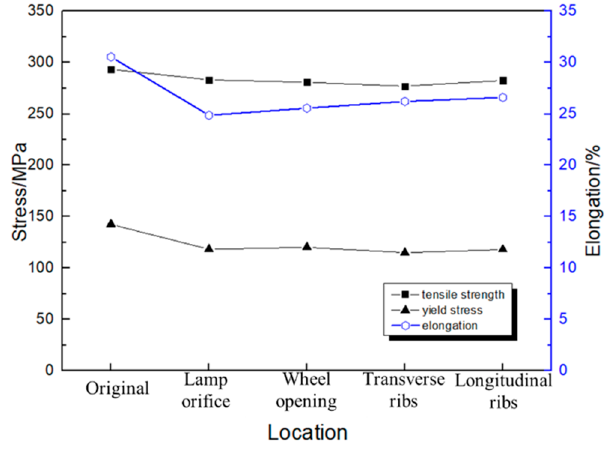
Figure 17. Mechanical properties of the material after the forming process.